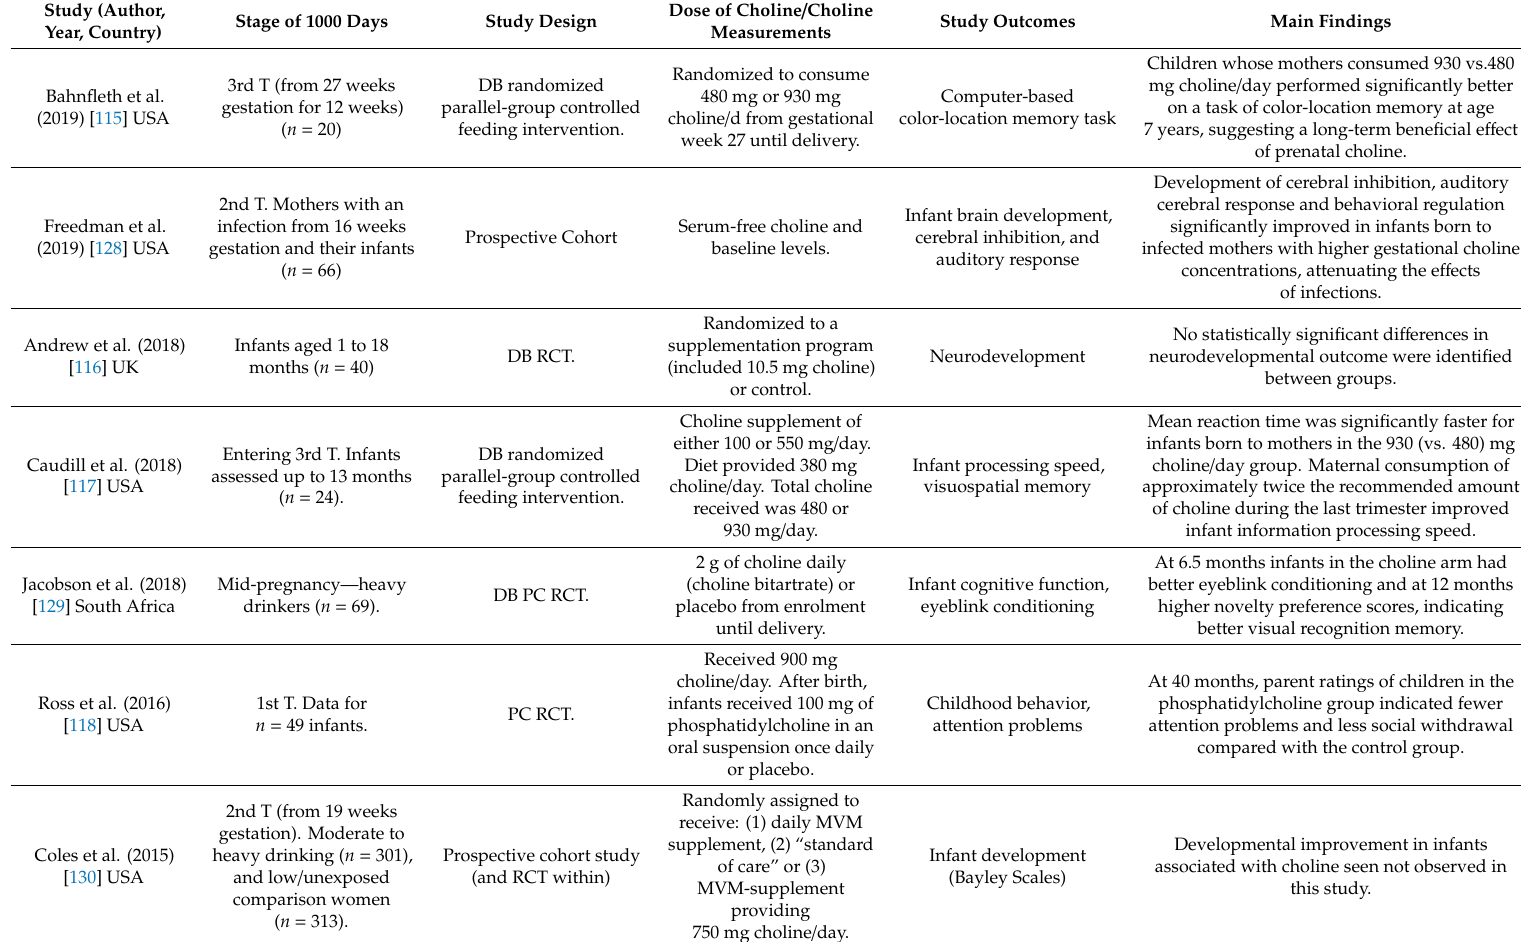
Table 2. Human studies investigating inter-relationships between choline, brain function and neurological